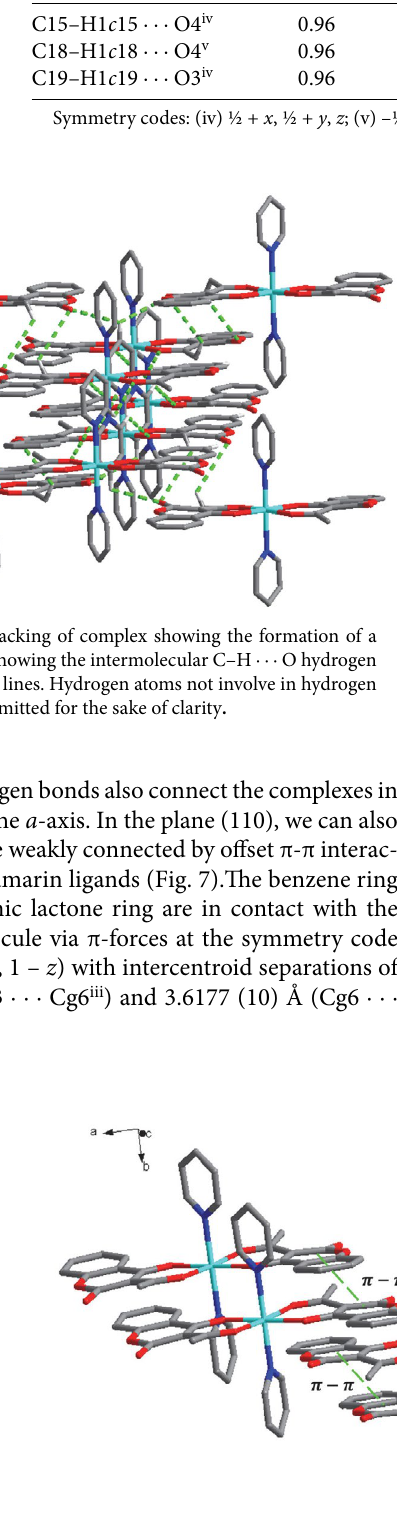
Figure 7. Crystal packing of complex showing a weak offset π–π stacking interactions between coumarin ligands in (110) plane. The green dotted line represents π–π stacking interactions. Hydrogen atoms have been omitted for